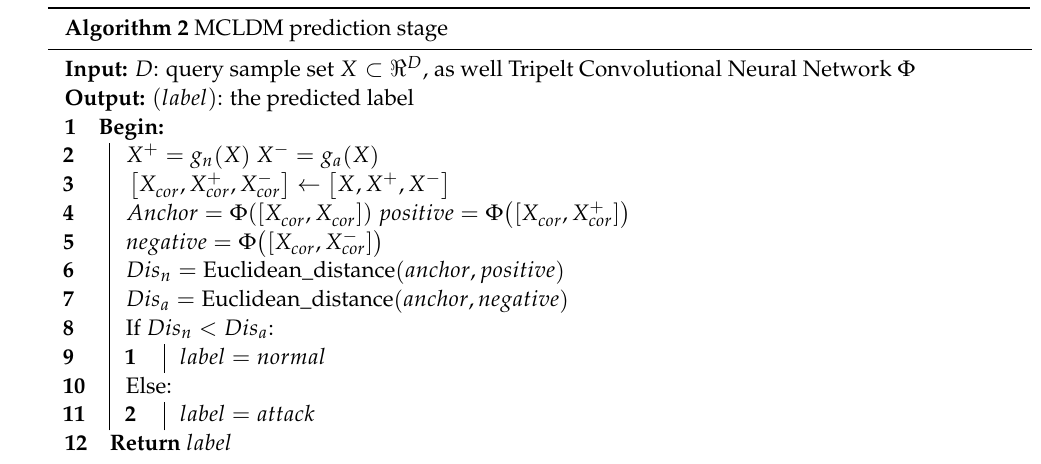
Algorithm 2 MCLDM prediction stage